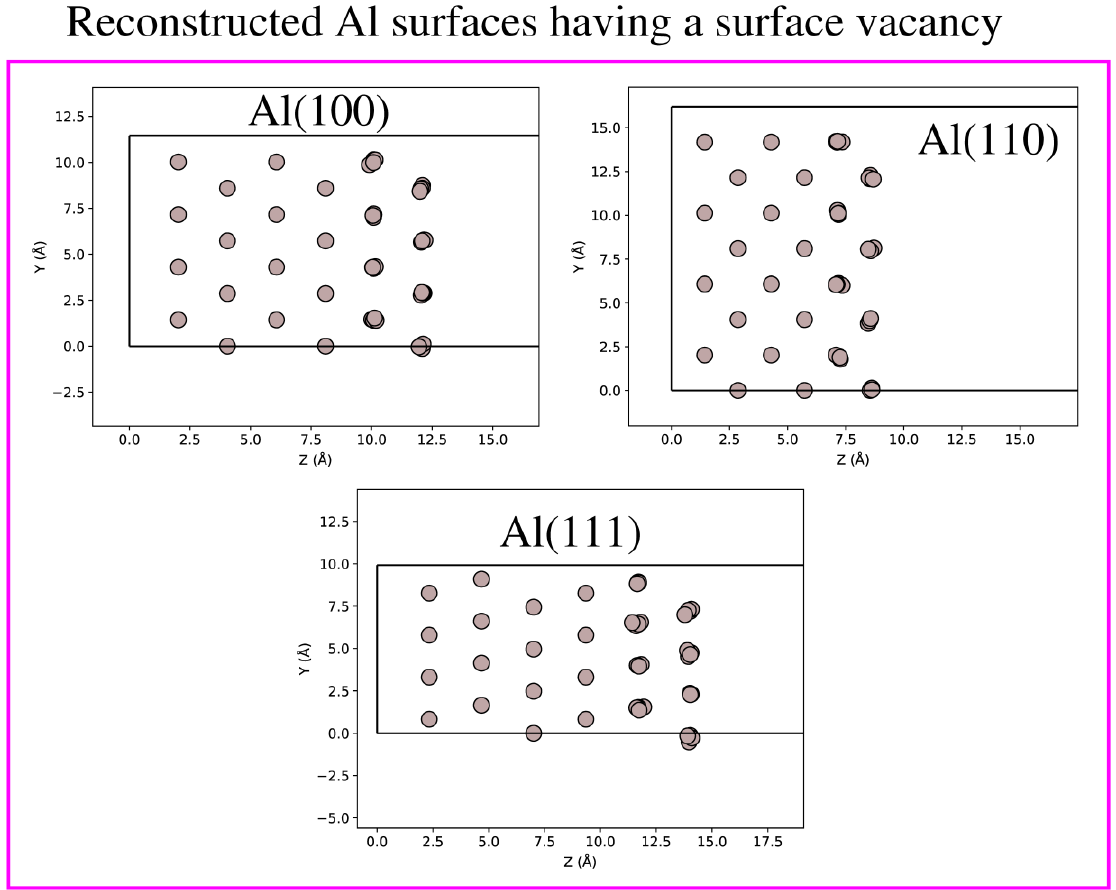
Figure 1. Reconstructed Al(100), Al(110), Al(111) slabs having a surface vacancy. Note that the atoms in the two top most layers were allowed to relax while the atoms occupying the four bottom layers were